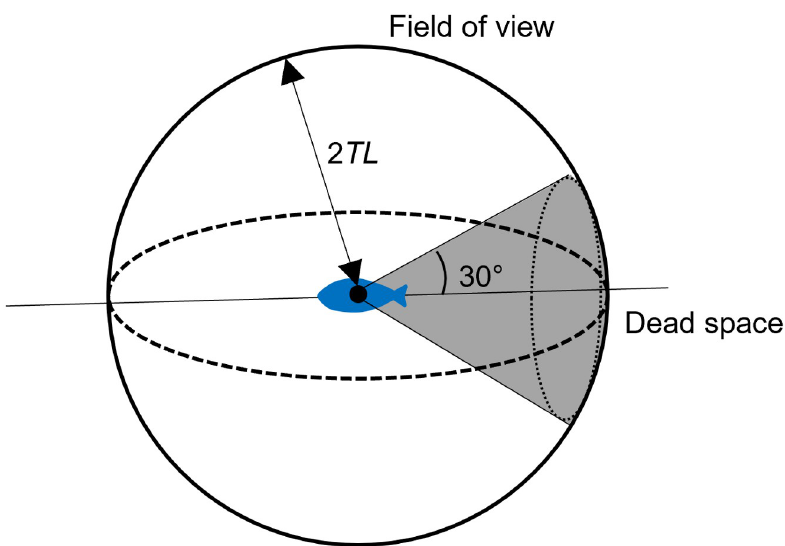
Fig 3. Schematic of an individual fish and its field of view. The field of view was defined to be a simple sphere with a radius twice the total length, 2 TL i . The space behind within an angle of 30 º was considered “dead space”. n